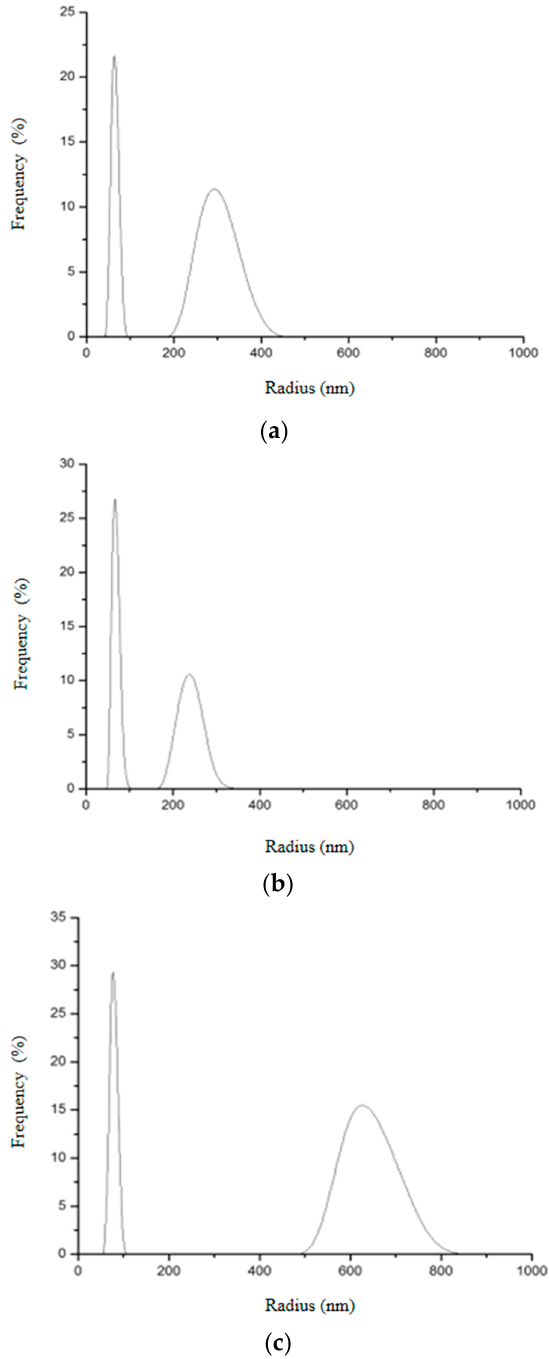
Figure 16. Hydrodynamic radius distribution measured in triplicate ( a – c ) for SiO 2 -Gd 2 O 3 :Eu 3+ nano- particles, indicating that they also tend to form clusters of different sizes in aqueous